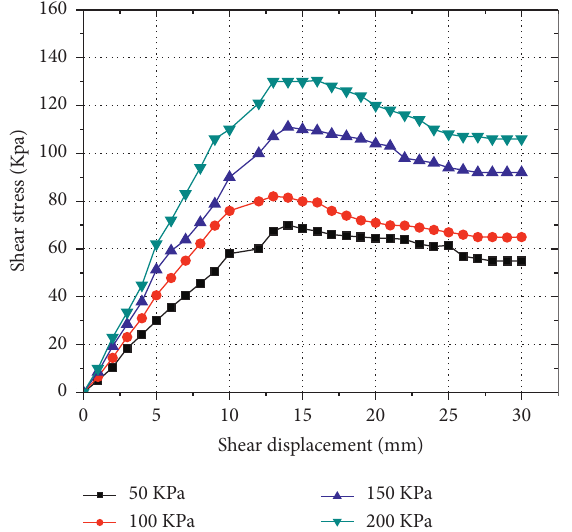
Figure 1: Shear strength curve of structural plane. Table 1: Shear strength parameters and fitting relationship of the structural plane. Normal stress, σ n (MPa)